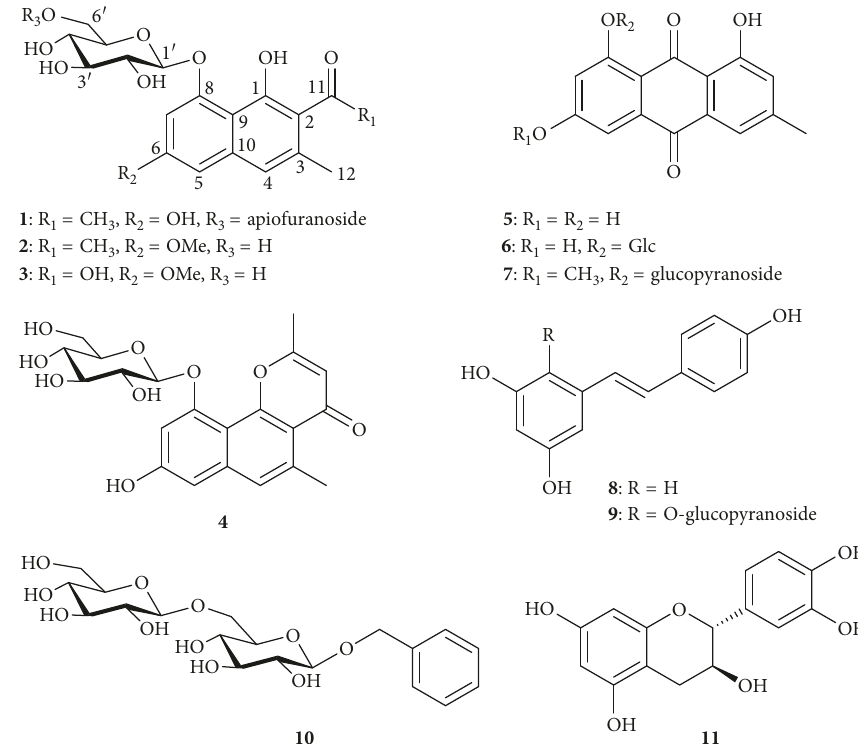
Figure 1: The structure of compounds 1 – 11 isolated from Fallopia